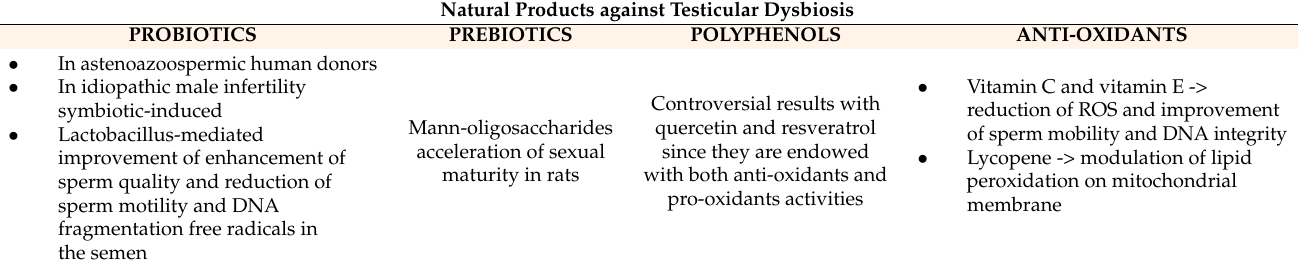
Table 1. Natural products for the correction of testicular dysbiosis. Both probiotics and synbiotics are able to improve sperm quality and motility in male infertility. In rats, manno-oligosaccharides (prebiotics) promote sexual maturity. Polyphenols exert both antioxidant and pro-oxidant activities. Among antioxidants, vitamin C and vitamin E are able to reduce ROS generation and improve sperm mobility and DNA integrity. Lycopene enhances sperm performance via lipid peroxidation on mitochondrial